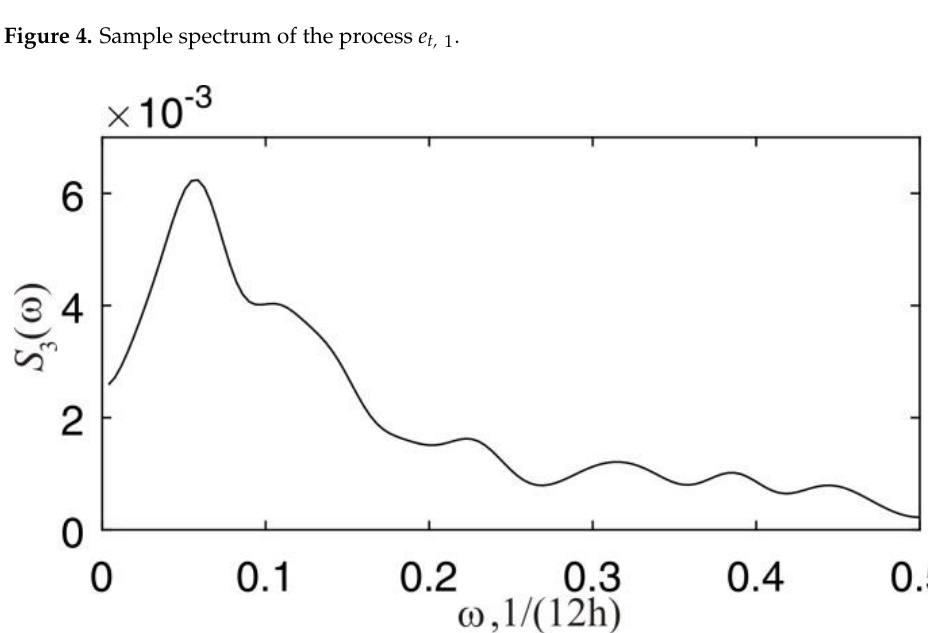
Figure 5. Sample spectrum of the process e t, 3 .